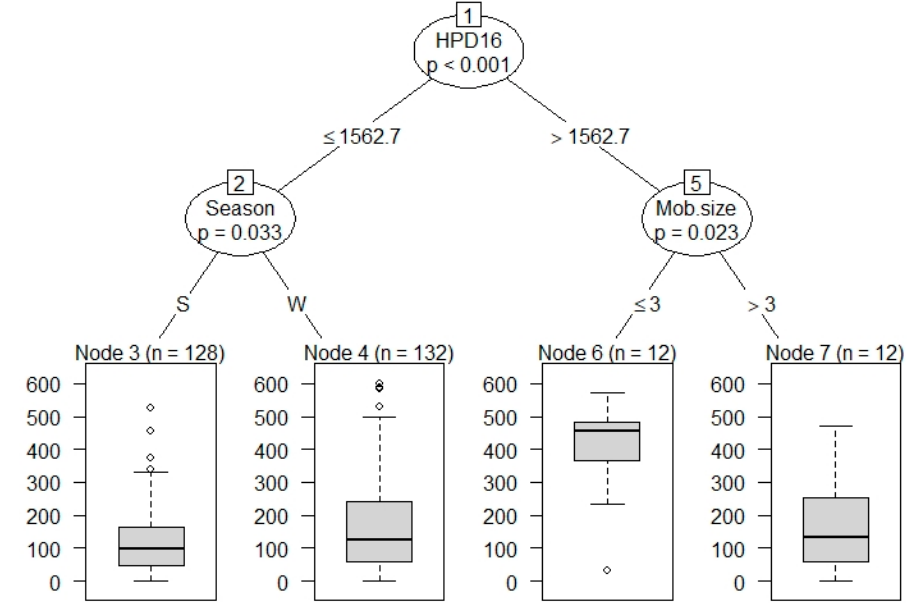
Figure 2. Conditional inference tree showing variables predicting the total time spent vigilant (sec) during ten-minute intervals ( y -axis) by eastern grey kangaroos (HPD16—human population densities (persons/km 2 ) as of 2016).